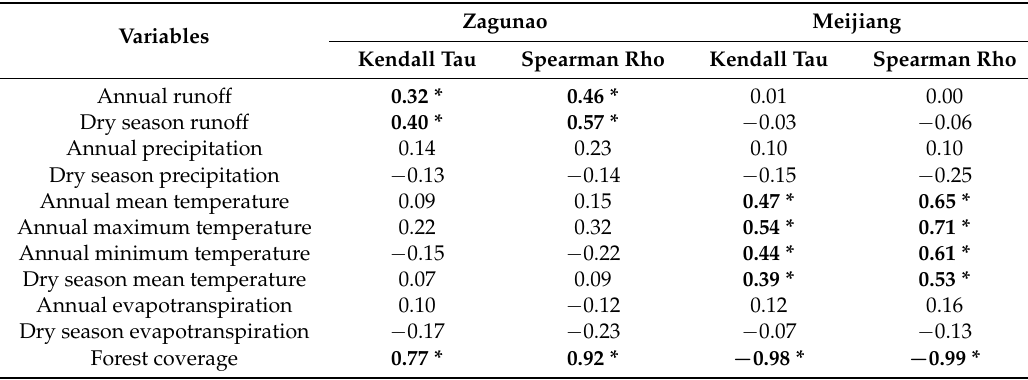
Table 3. Results of trend analysis in the study watersheds.